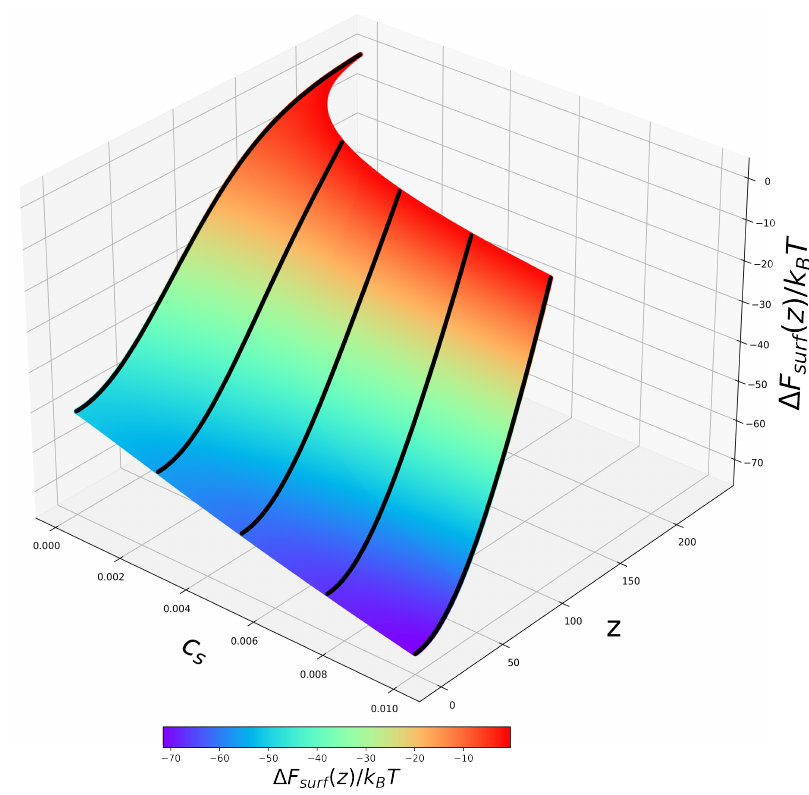
Figure 6. 2D profiles of the free energy ∆ F surf ( z , C s ) of short-range (attractive) interactions of the BSA globule with the PE brush-forming chains plotted according to Equation